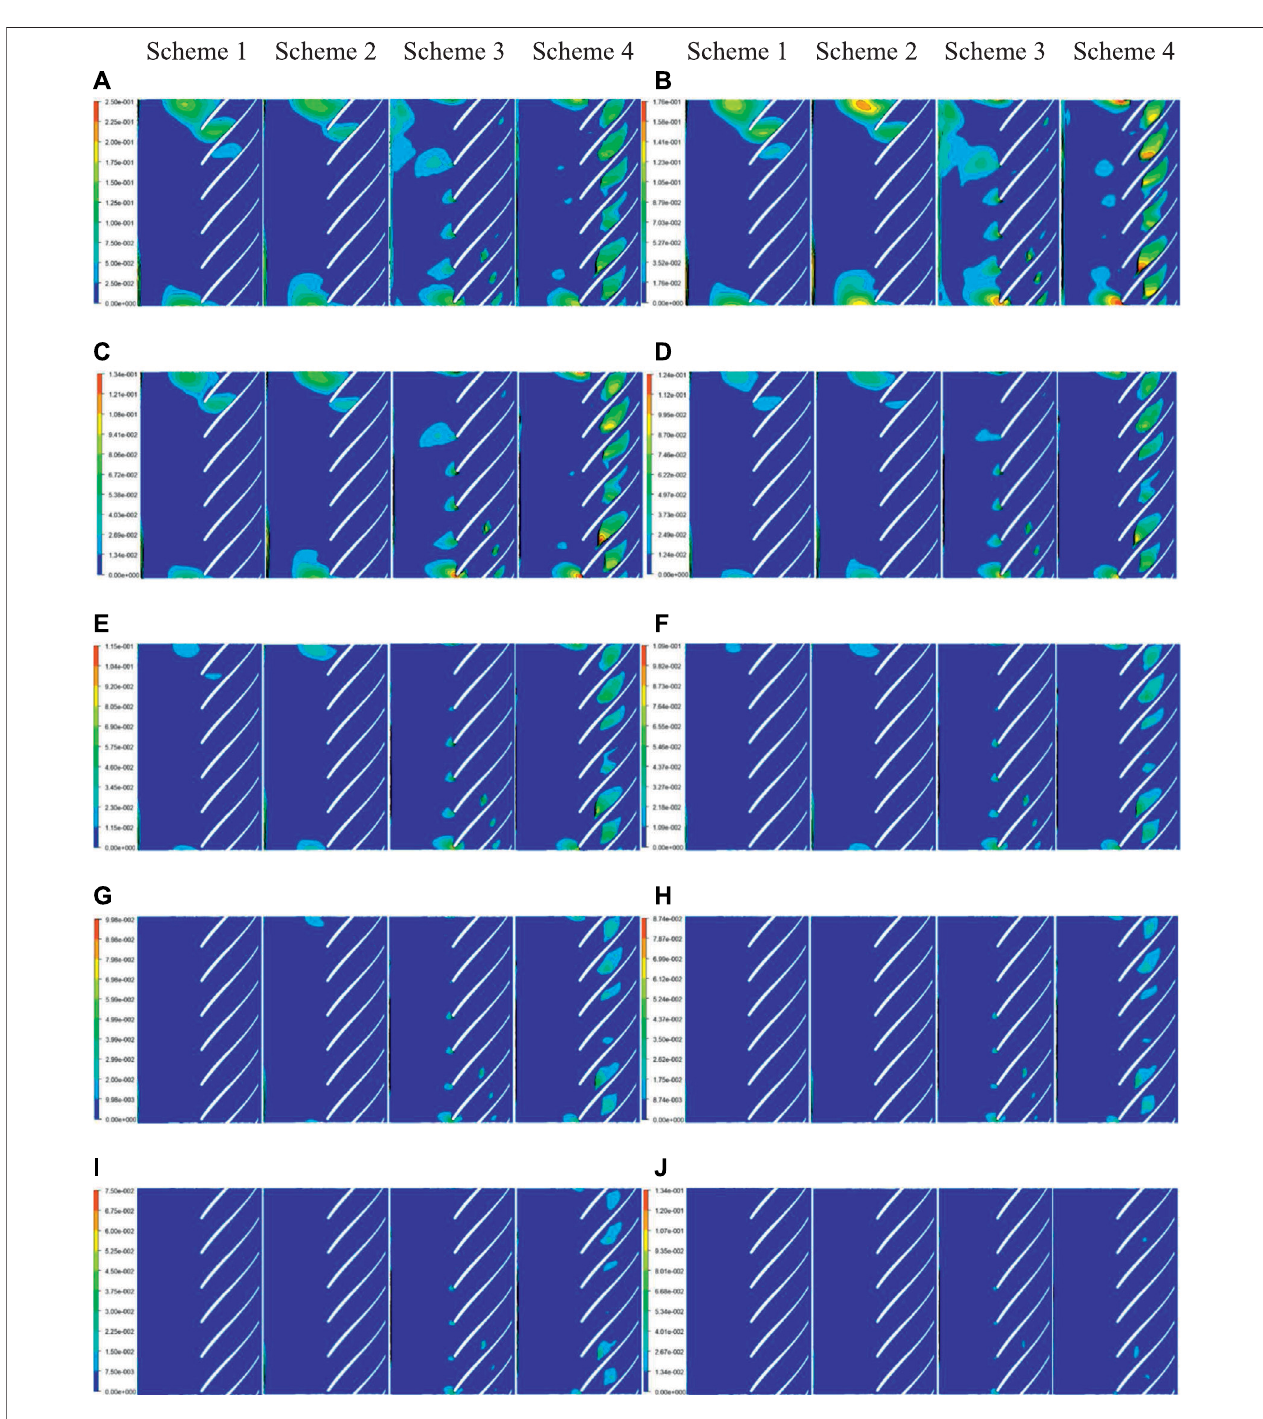
FIGURE4| DistributionofdifferentsizesbubblesontheSpan0. (A) Thedistributionof1 mmbubbles. (B) Thedistribution of2 mmbubbles. (C) Thedistributionof 3 mm bubbles. (D) The distribution of 4 mm bubbles. (E) The distribution of 5 mm bubbles. (F) The distribution of 6 mm bubbles. (G) The distribution of 5 mm bubbles. (H) The distribution of 6 mm bubbles. (I) The distribution of 5 mm bubbles. (J) The distribution of 6 mm